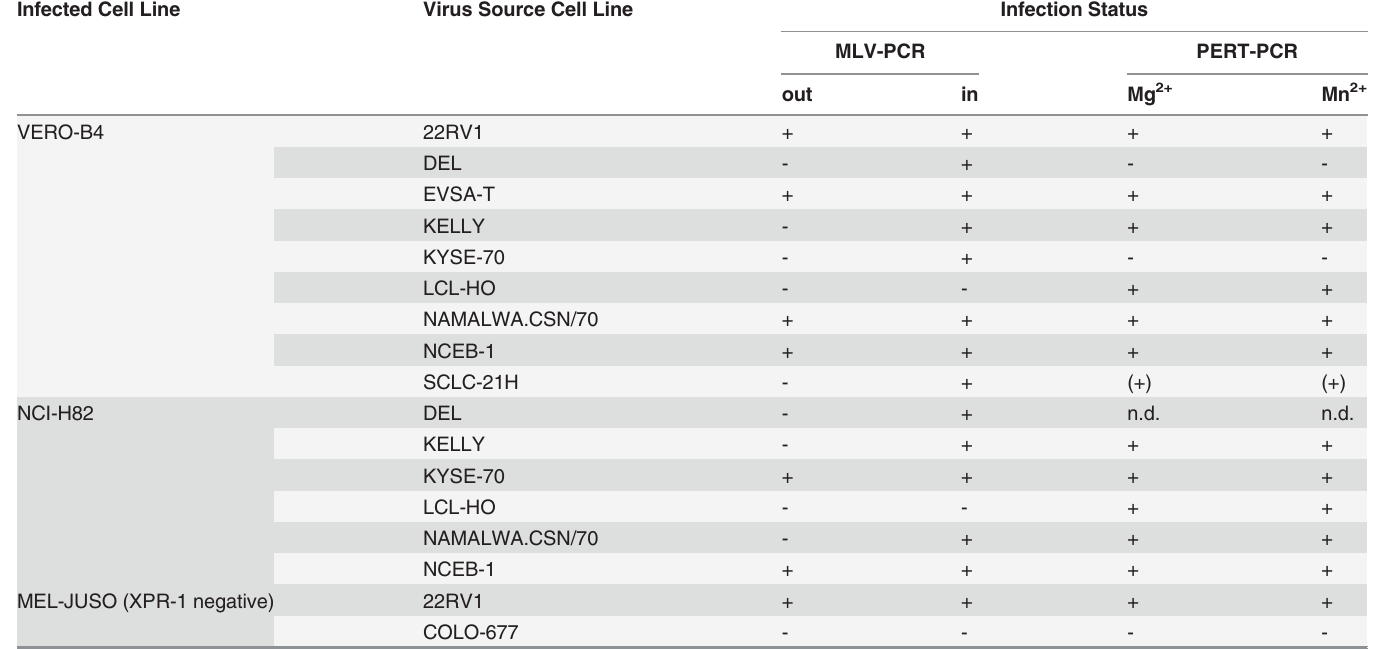
Table 3. Infection experiments of MLV-negative cell lines with MLV from infected cell